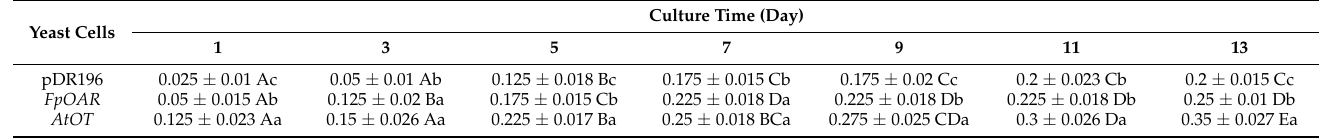
Table 2. Variation of dry weight for different recombinant yeast cells under 2 mM oxalic acid stress.